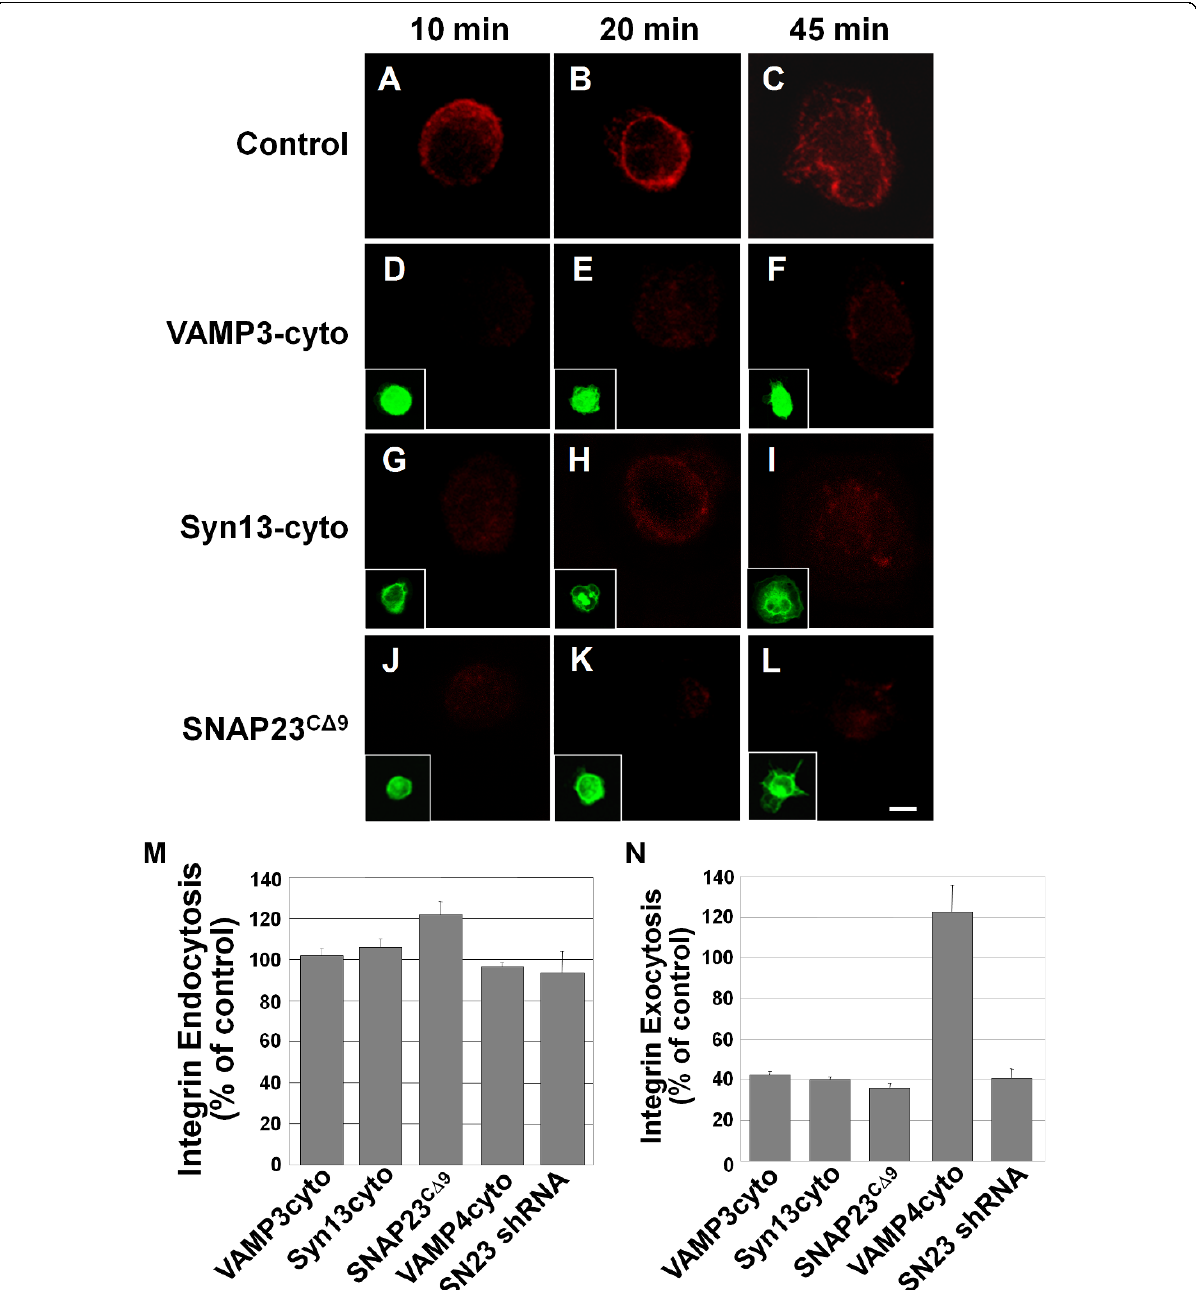
Figure 4 Dominant-negative SNARE domains inhibit b 1 integrin exocytosis . CHO-K1 cells were transiently transfected for 21 h with GFP- tagged constructs of truncated syntaxin13 (Syn13cyto)[D-F], VAMP3 (VAMP3cyto)[G-I], VAMP4 (VAMP4cyto) or SNAP23 (SNAP23 C Δ 9 - 15 h transfection) [J-L]. Untransfected control cells are shown in A-C. HeLa cells were transfected with a SNAP23 shRNA construct (SN23 shRNA) for 72 h. Cells were incubated with b 1 integrin antibody in serum free media for 3 h to allowing internalization of the label. Then the cells were lifted with trypsin, removing remaining surface label, and were plated on 20 μ g/mL FN for 10 min (A, D, G, J,), 20 min (B, E, H, K,) or 45 min (C, F, I, L). For exocytosis assays, cells were fixed and any surface exposed labeled-integrin was stained with AlexaFluor 594 secondary antibody (A-L, data for 20 min of adhesion shown in N). Insets show expression of GFP-tagged constructs (D-L). Images are 3 D reconstructions of a z-series. Scale bar represents 10 μ m. (M and N) Integrin immunofluorescent staining at 20 min. was quantified in micrographs using ImageJ software. (M) To assess endocytosis of labeled integrin, cells were permeablized with 0.2% Trition X-100 in PBS before staining with AlexaFluor 594 secondary antibody (percent of non-transfected control). (N) Labeled integrin detected on the cell surface in non-permeabilized cells (percent of non- transfected control). Means ± SEM from three independent experiments (at least 20 cells per experiment) are shown in M and